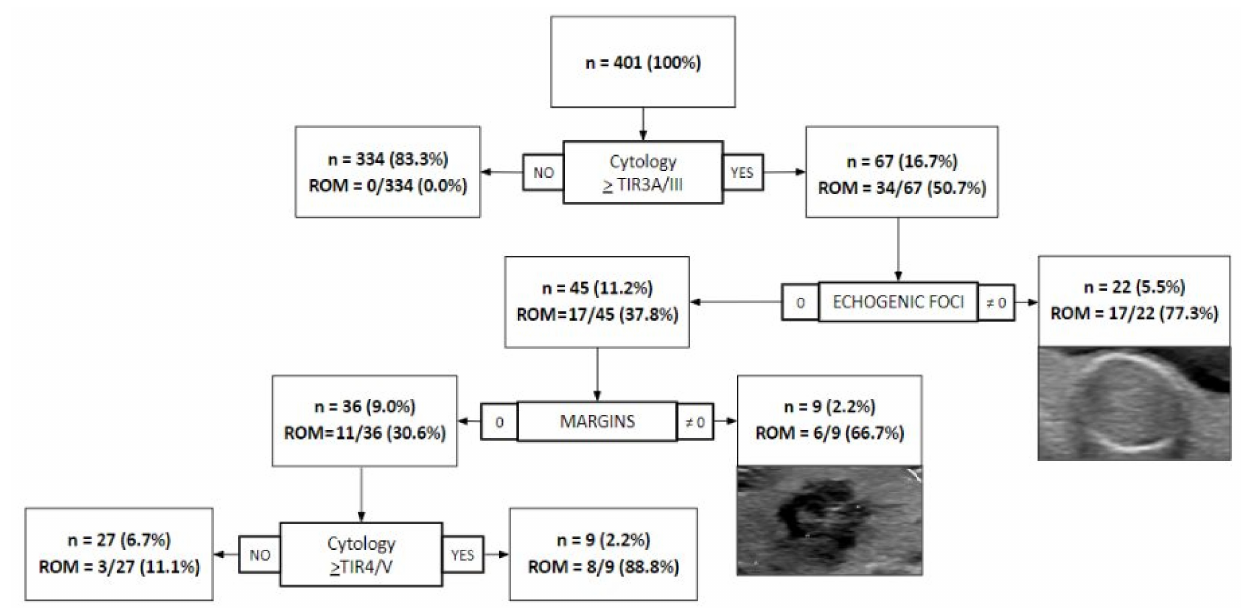
Figure 1. Nodules’ risk of malignancy (ROM, based on histology or follow-up) using a combination of cytology with ultrasound ACR features of the echogenic foci and